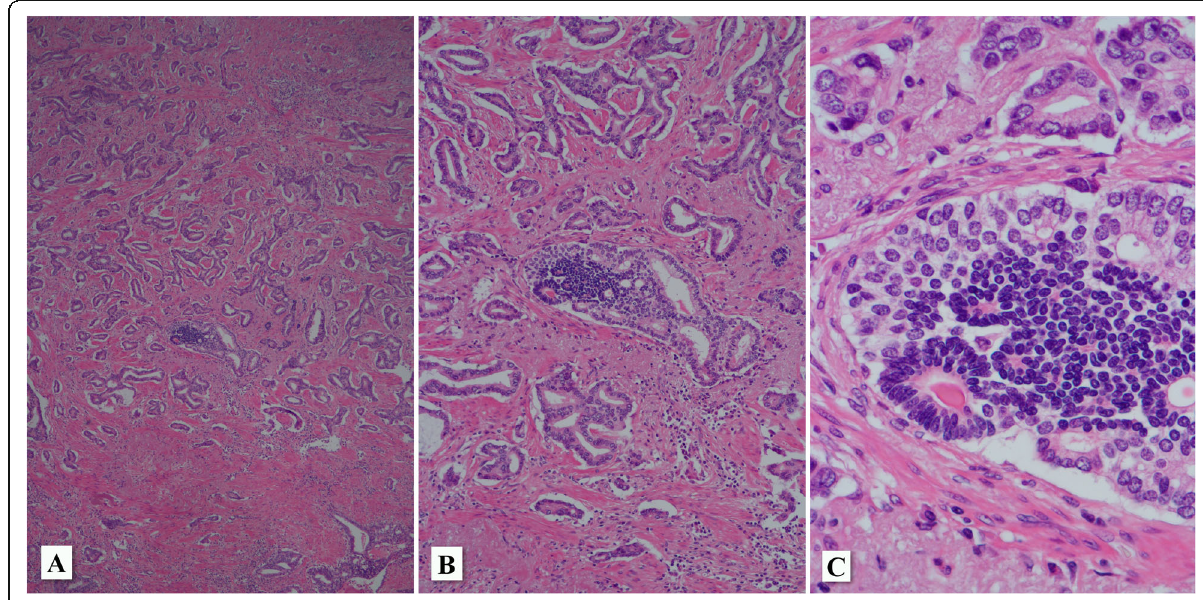
Fig. 4 Small cell-like change in intraductal carcinoma. Aggregates of small cells in the center of the lesion show occasional lumen and rosette formation. Hematoxylin and eosin stain: A (40x), B (100x) and C